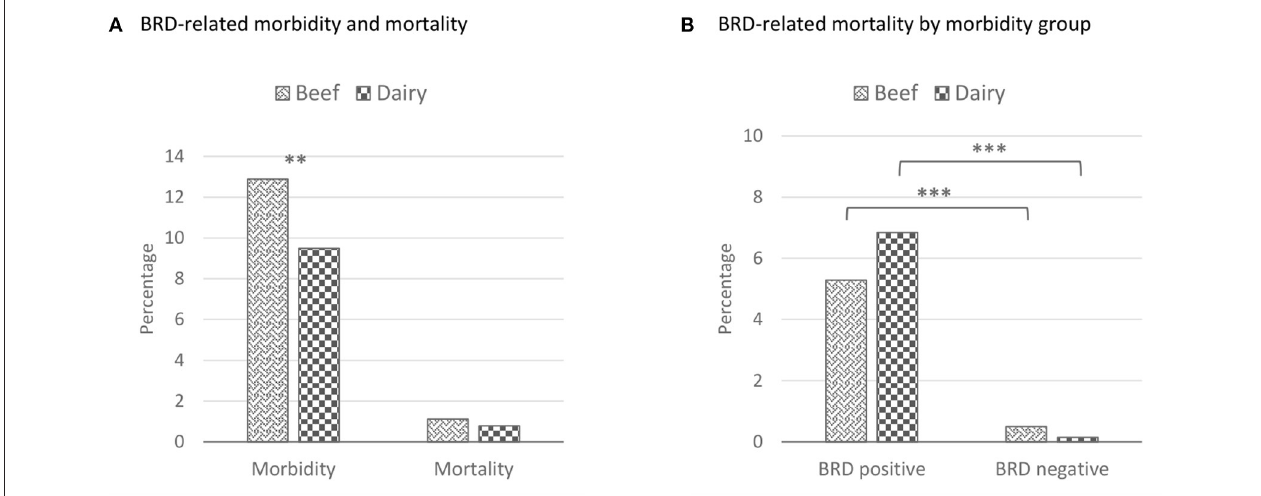
FIGURE 3 | Proportion of cattle treated at least once for BRD and/ or succumbed to BRD during the first 120 d of the feeding period for beef and dairy-type cattle. These percentages represent unadjusted proportions. The asterisks represent the statistical test significance level as follows: “**” 0.01, “***” 0.001. BRD, bovine respiratory disease; Tx, treatment. (A) Beef morbidity proportion: 265/2,055 DNPS; beef mortality proportion: 23/2,055 DNPS; dairy morbidity proportion: 73/769 DNPS; dairy mortality proportion: 6/769 DNPS. Morbidity X 2 (1, n = 2,428) = 6.15, p = 0.0132; mortality X 2 (1, n = 2,428) = 0.63, p = 0.4264. (B) BRD-treated beef mortality proportion: 14/265; non-BRD treated beef mortality proportion: 9/1,790; BRD-treated dairy mortality proportion: 5/73; non-BRD treated dairy mortality proportion: 1/696. Beef X 2 (1, n = 2,055) = 48.04, p < 0.001; dairy Fisher Exact (1, n = 769) = 35.27, p <